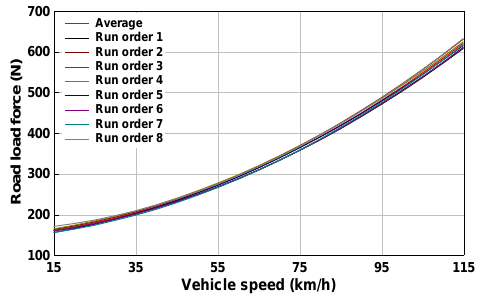
Figure 4. Road load graph from 15 km/h to 115 km/h.